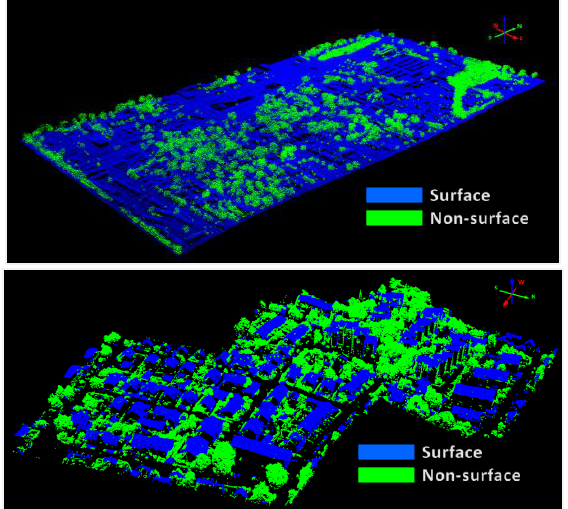
Figure 4. Bloomington lidar point cloud (top) and Vaihingen off- ground lidar points (bottom) labeled as surface (blue) and non- surface (green) points.